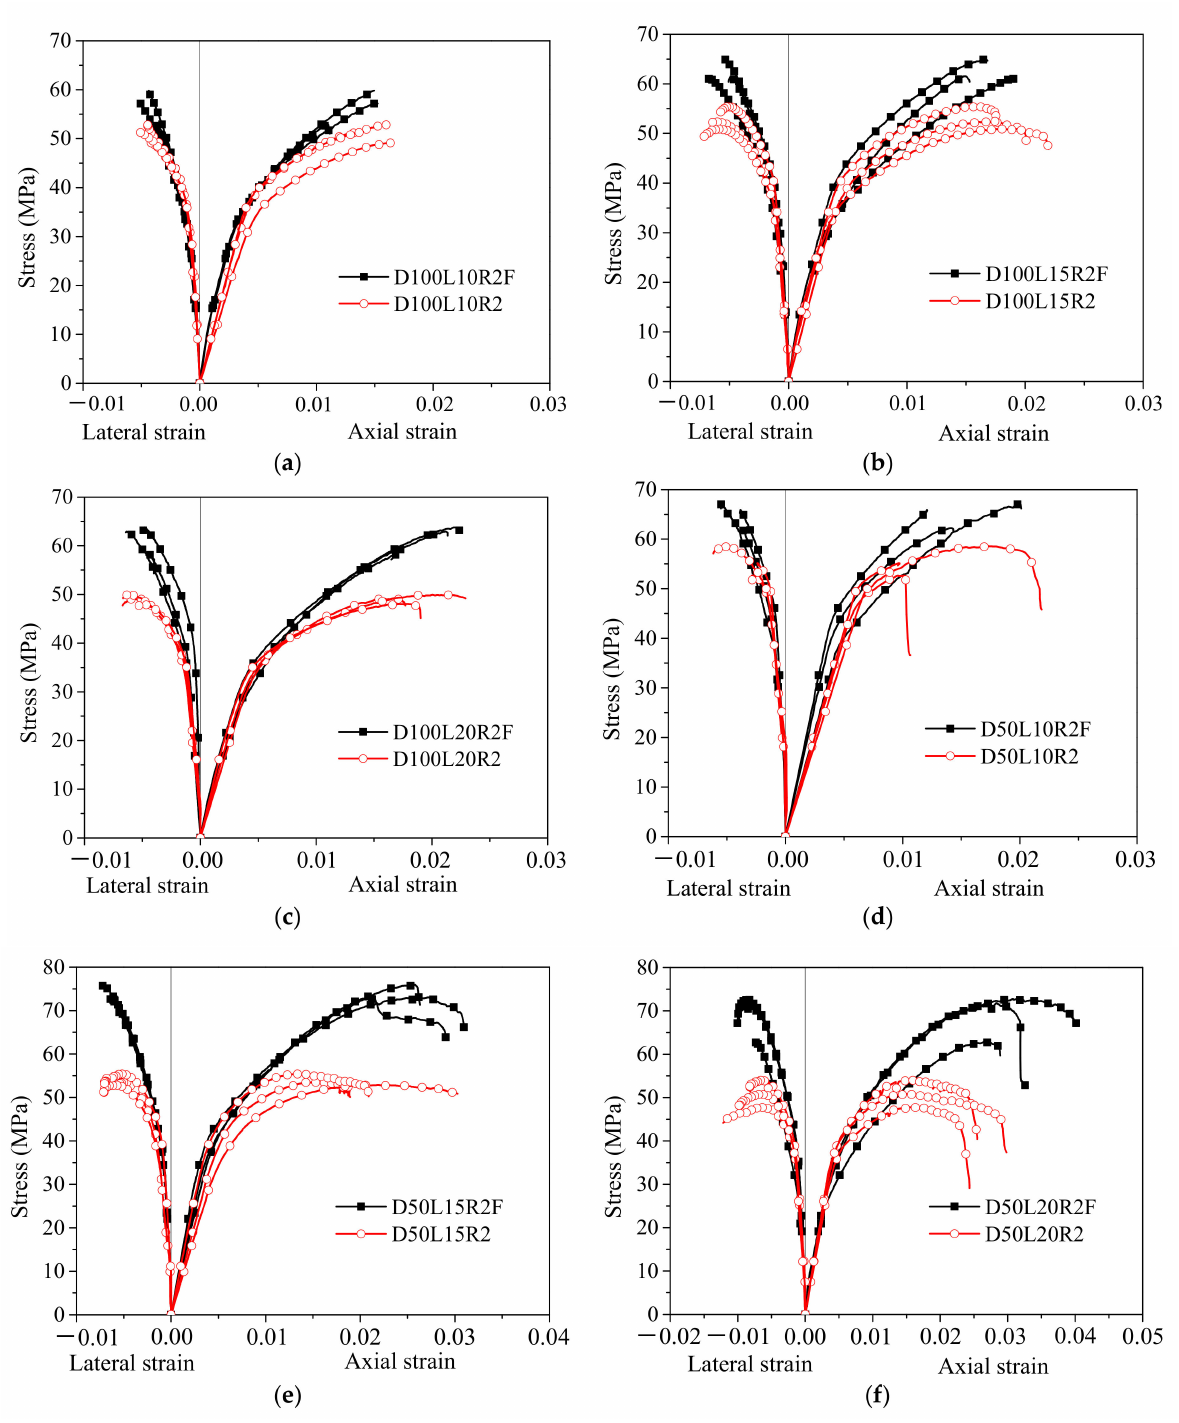
Figure 6. Comparison of stress–strain curves between foam-filled and unfilled bamboo